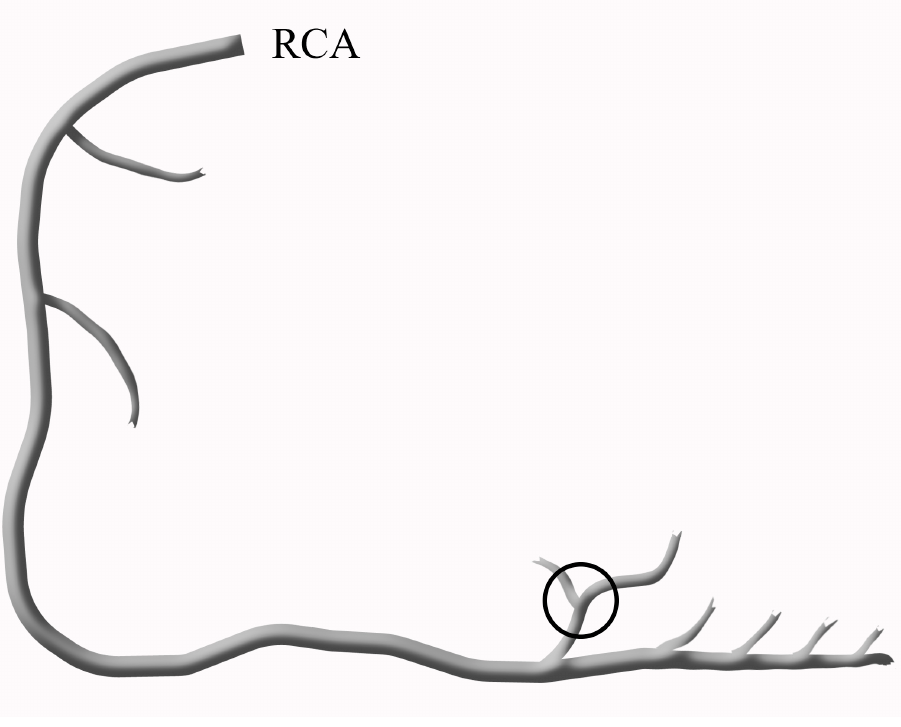
Figure 2. The schematic diagram of the RCA shows the distal landmark, which is defined as the first posterolateral artery branch of the RCA.